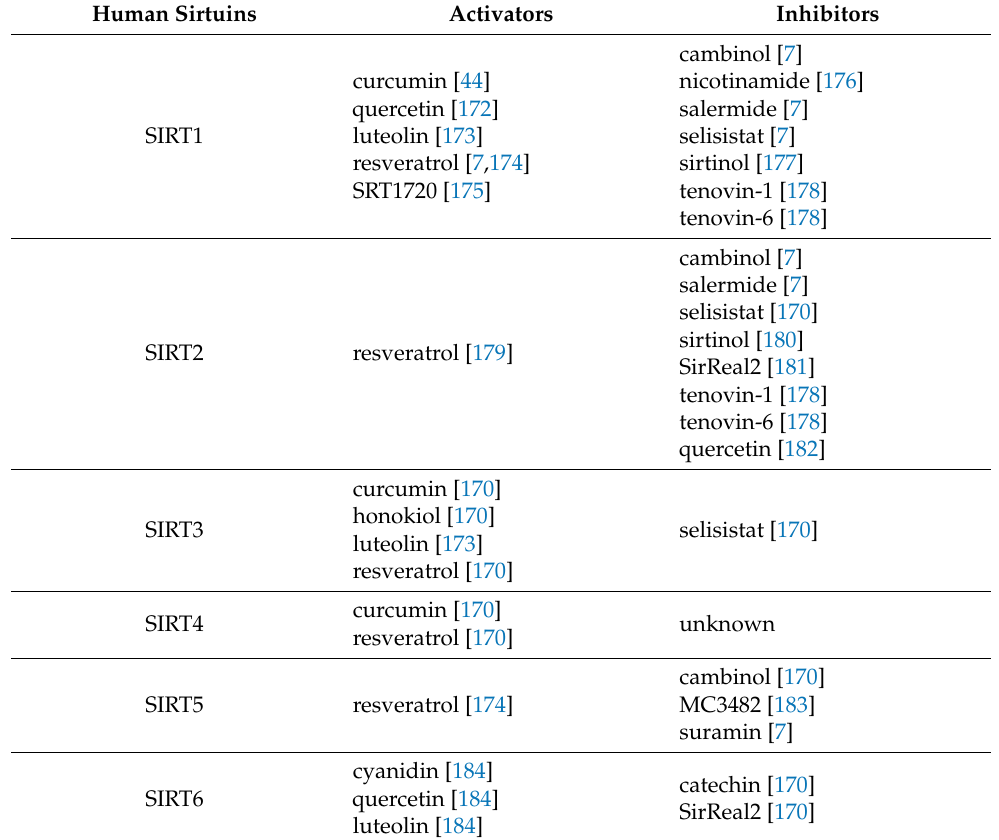
Table 3. The most important known SIRT